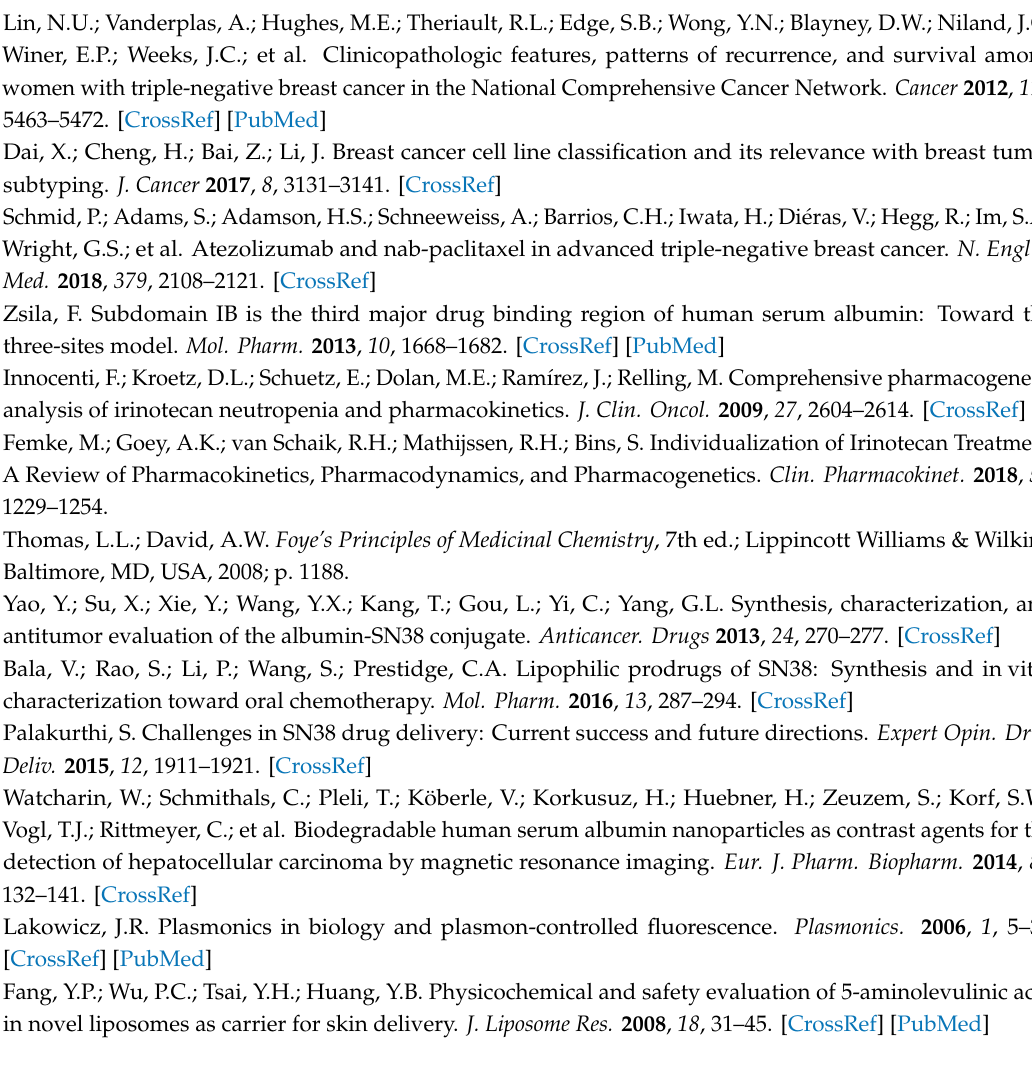
Figure S1: SEM images, Table S1: Mathematical